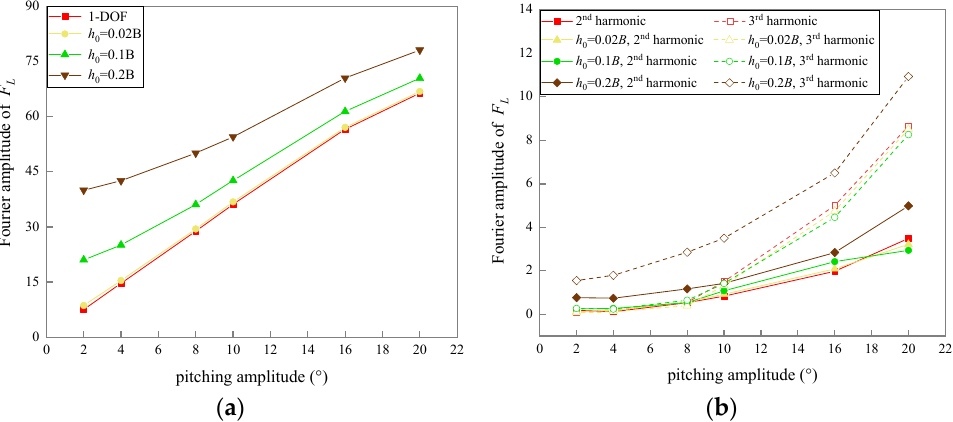
Figure 16. Variation in Fourier amplitude of aerodynamic lift with pitching amplitude. ( a ) The fundamental frequency; ( b ) Second harmonic and third harmonic.